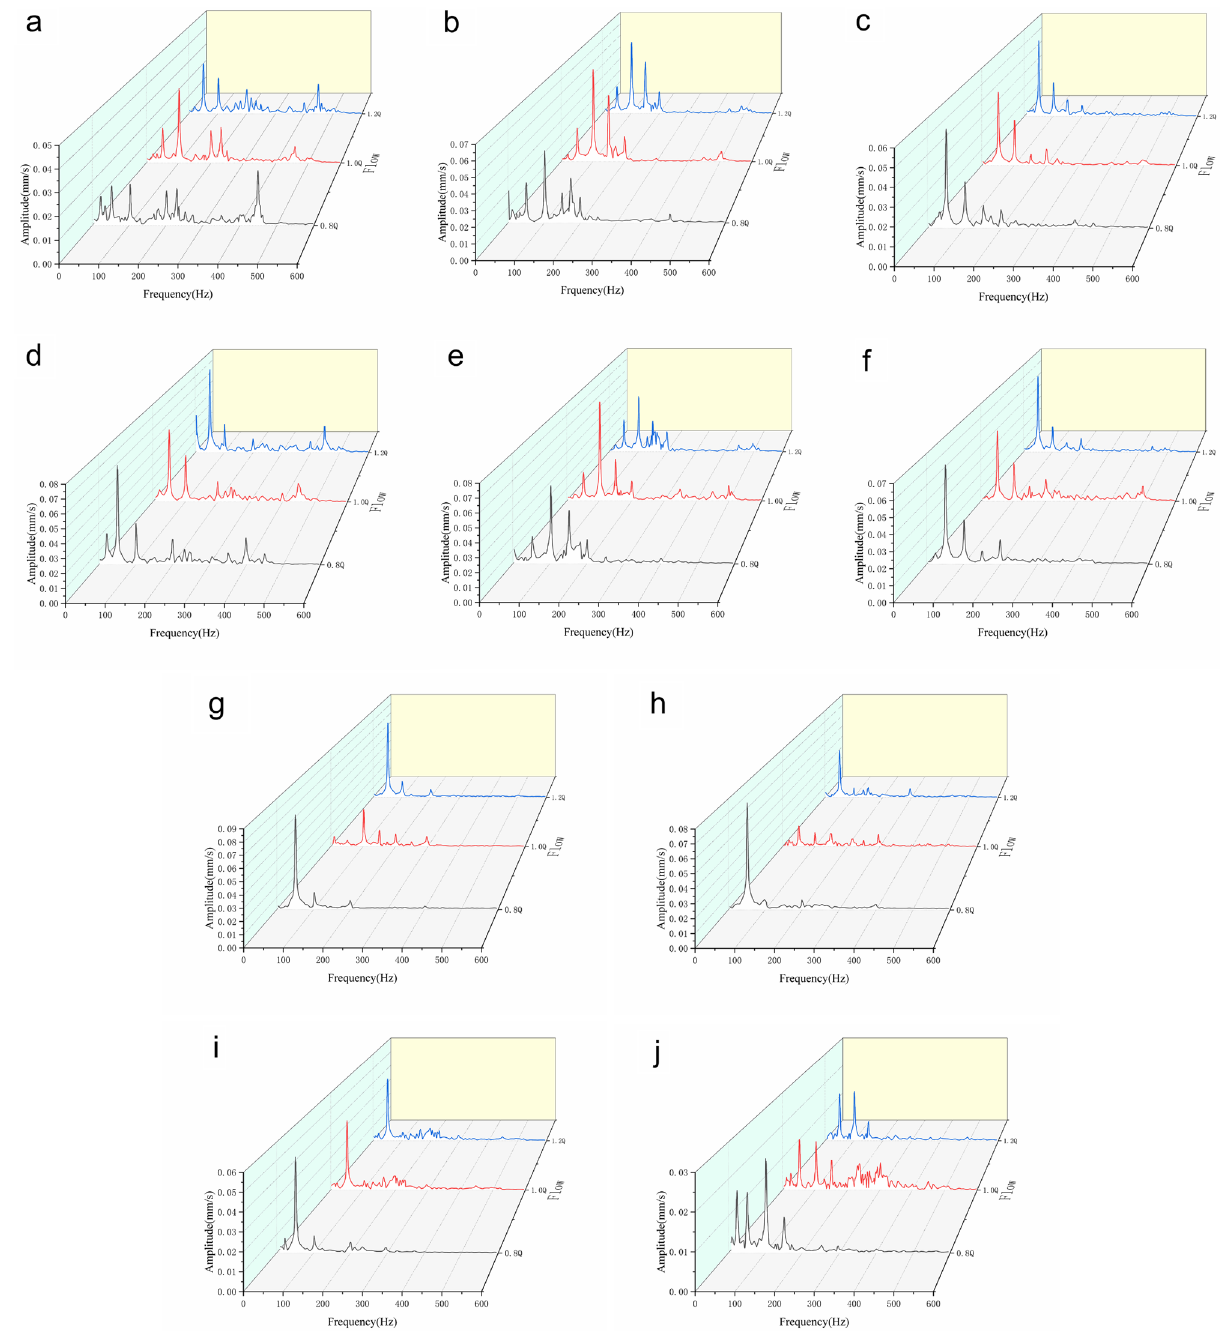
Figure 13. Frequency domain diagrams of 10 measuring points at different flow rates. ( a ) Point 1. ( b ) Point 2. ( c ) Point 3. ( d ) Point 4. ( e ) Point 5. ( f ) Point 6. ( g ) Point 7. ( h ) Point 8. ( i ) Point 9. ( j ) Point